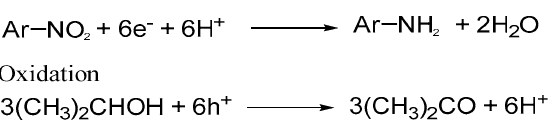
Figure 6. Schematic illustration on the photocatalytic reduction of 2,2-difluoromethyacetophenone (DFAP) on the UV irradiated TiO 2 . Reprinted with permission from reference [80]. Copyright (2016) Elsevier